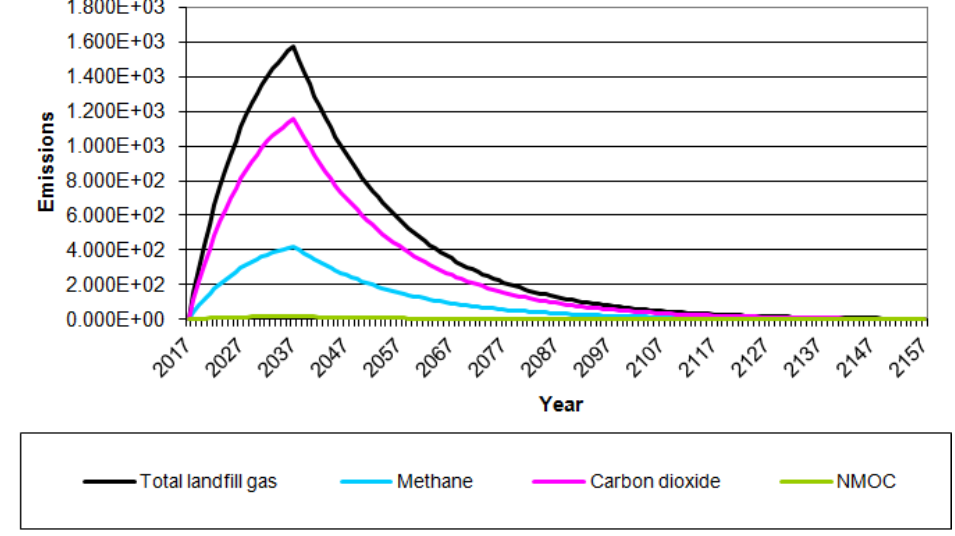
Fig 3. The amount of generated gas, methane, and carbon dioxide and NMOC,